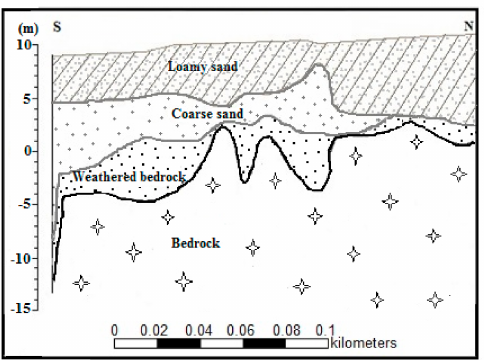
Figure 11. Cross-section through the island at the Brokopondo Sula (modified after Bleys [52]).